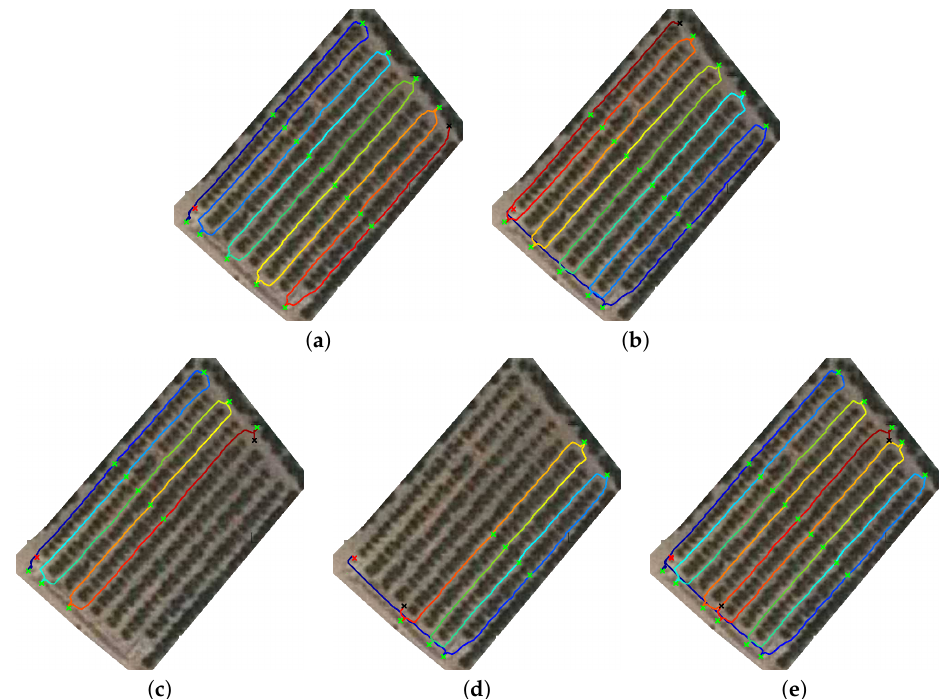
Figure 14. Determining path planning for a team composed by two robots (I). ( a ) path planning for robot 1 , ( b ) path planning for robot 2 , ( c ) real path for robot 1 , ( d ) real path planning for robot 2 , ( e ) superposition of (c) and (d).